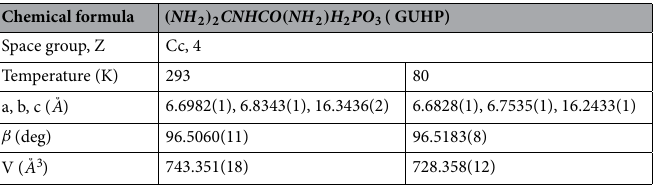
Table 1. Crystallographic characteristics, experimental data, and structure refinement parameters for GUHP.